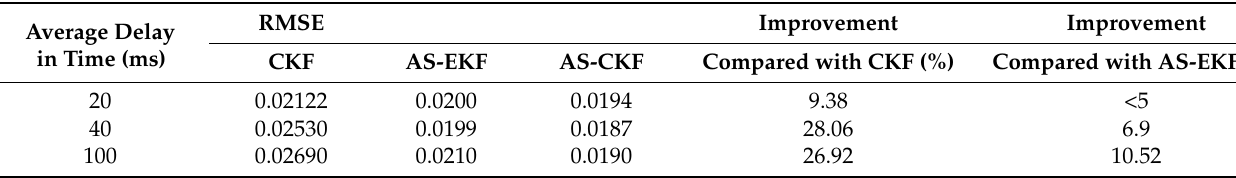
Table 3. RMSE error of velocity (m/s).